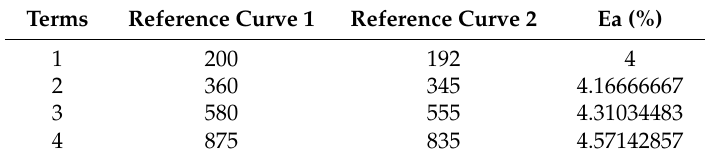
Table 3. Summary table of quantification of maximum percentage errors regarding of the wind